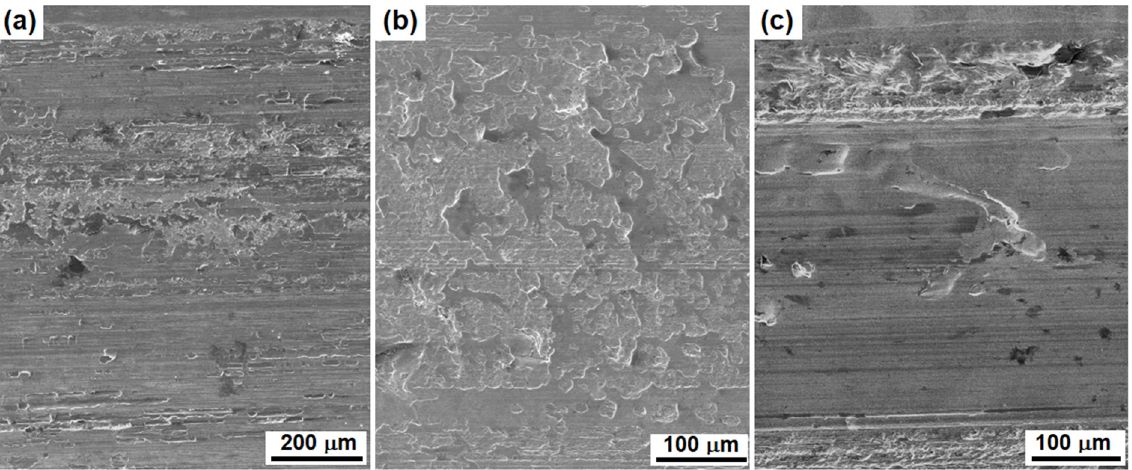
Figure 9. SEM micrographs showing the worn surfaces: ( a ) the M18 austenitic Hadfield steel; ( b ) the pearlitic rail steel; and ( c ) the martensitic 300 M steel.